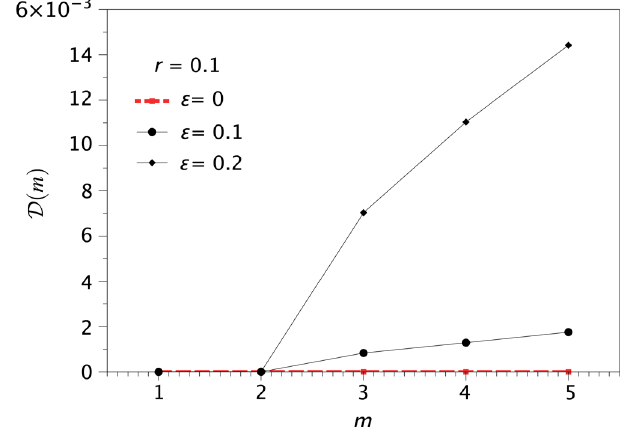
FIG. 8. Scenario 2. Normalized Kullback-Leibler divergence D ð m Þ between X ð t Þ and its Markovianized surrogate Y ð t Þ , in the case where both layers are complete graphs with different transition matrices and the switching rate is r ¼ 0 . 1 . The differ- ence is parametrized by ϵ (when ϵ ¼ 0 , both matrices are identical, and they increasingly differ with increasing values of ϵ ). The method detects multiplexity [ D ð m > 2 Þ > 0 ] with larger values as ϵ increases.